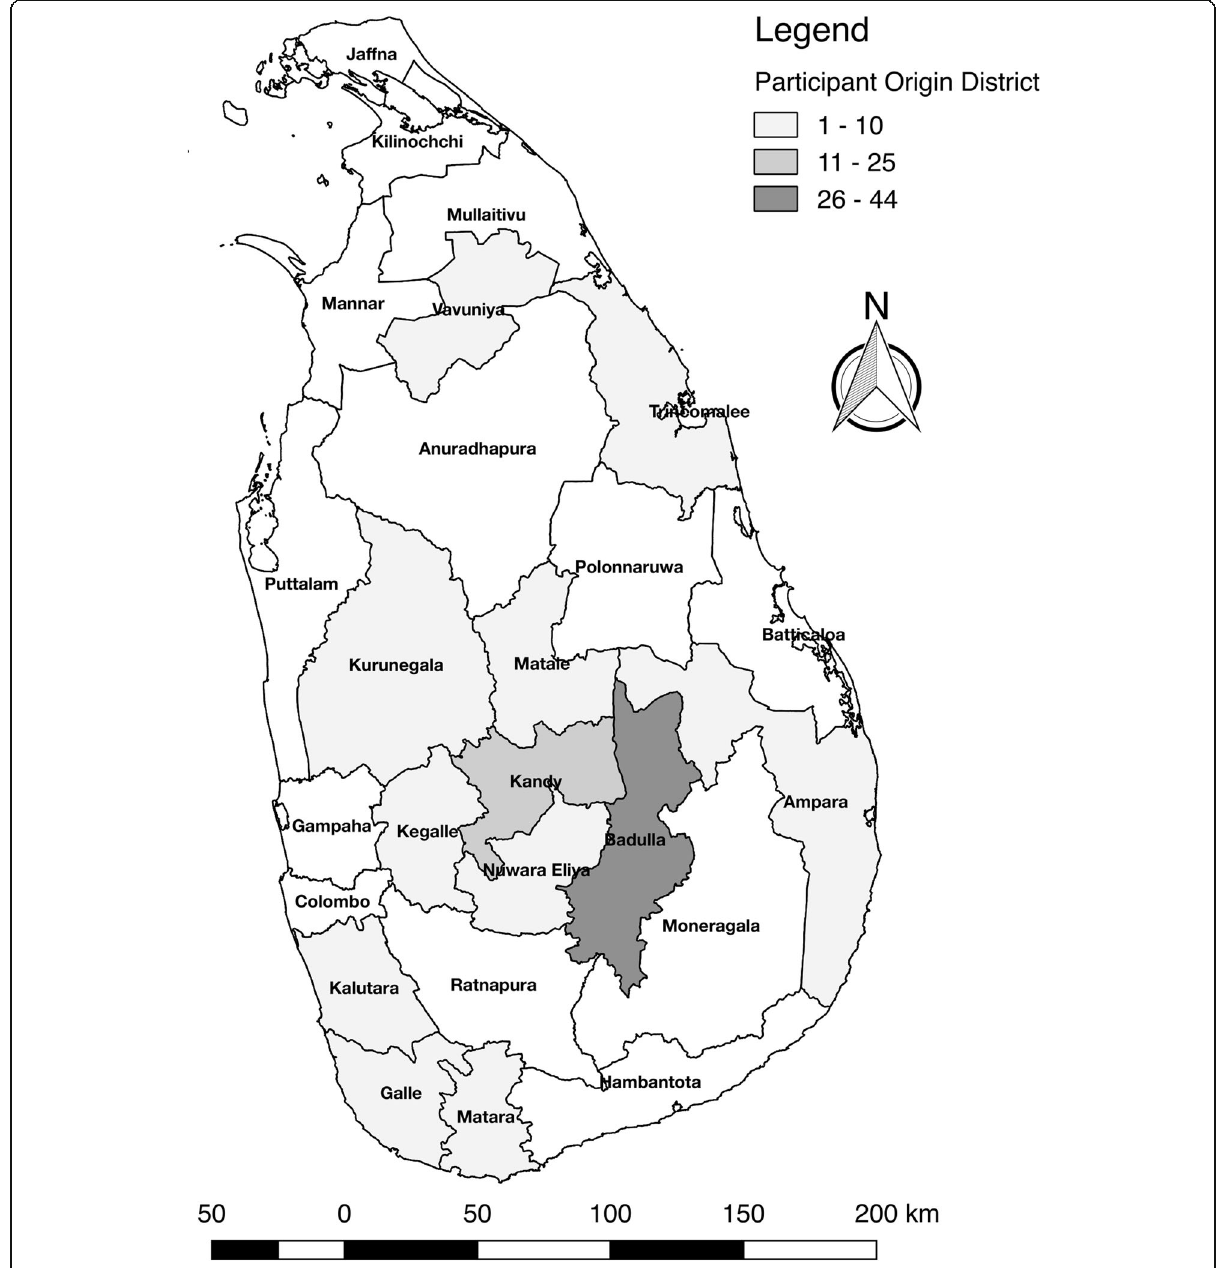
Fig. 1 Map of Sri Lanka by district indicating participant ’ s birth